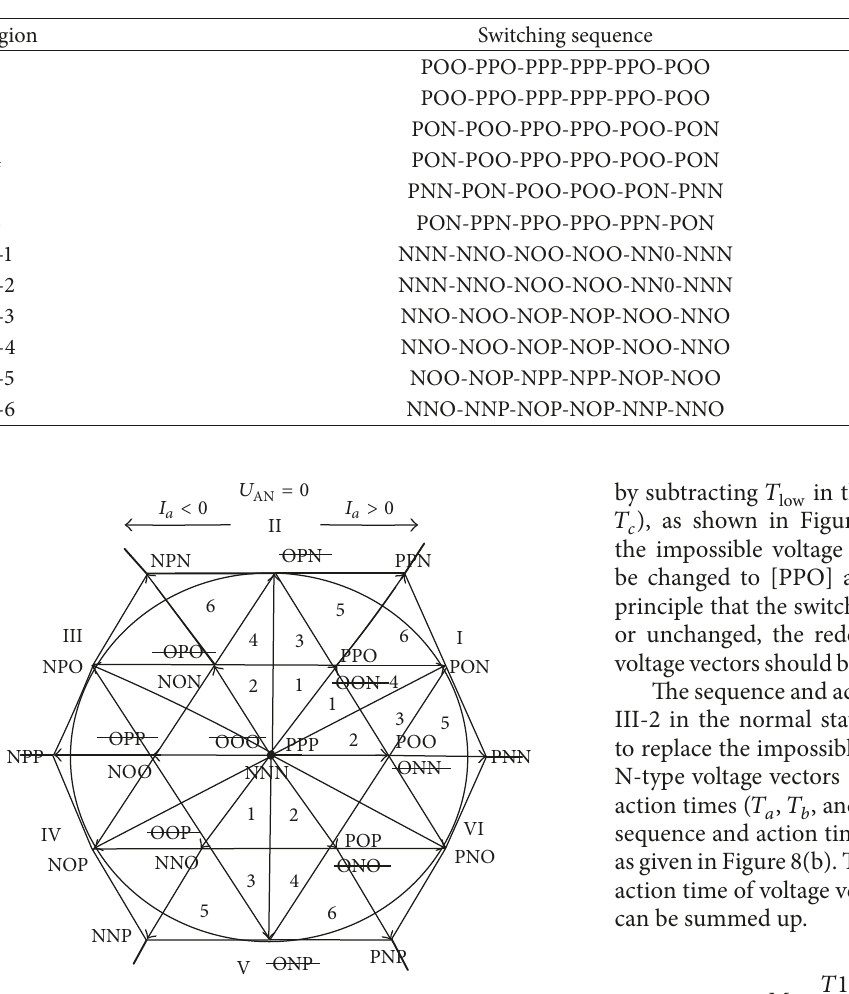
Figure 6: Voltage vector distribution after the fault tolerance.